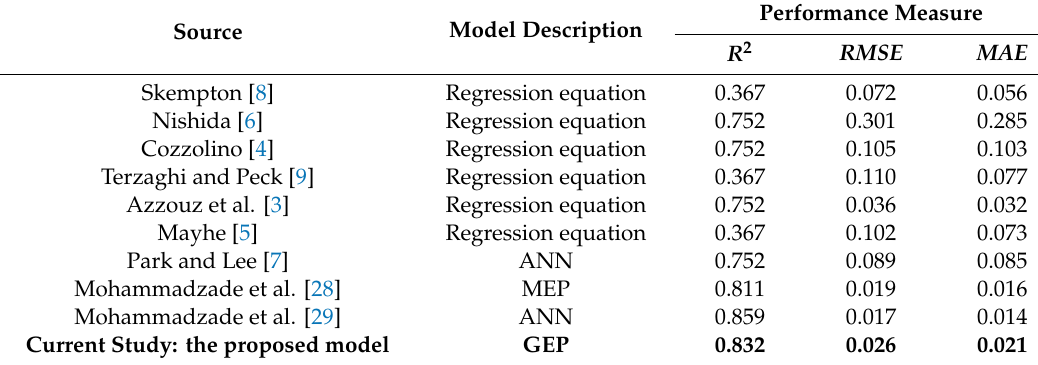
Table 5. Performance comparison of the current developed GEP-based model to existing models. MEP: multi-expression programming; ANN: artificial neural